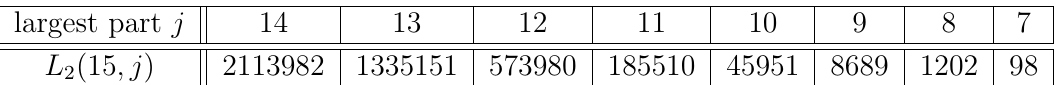
( n )(resp. M ( n )) of forcibly biconnected (resp. connected) 2